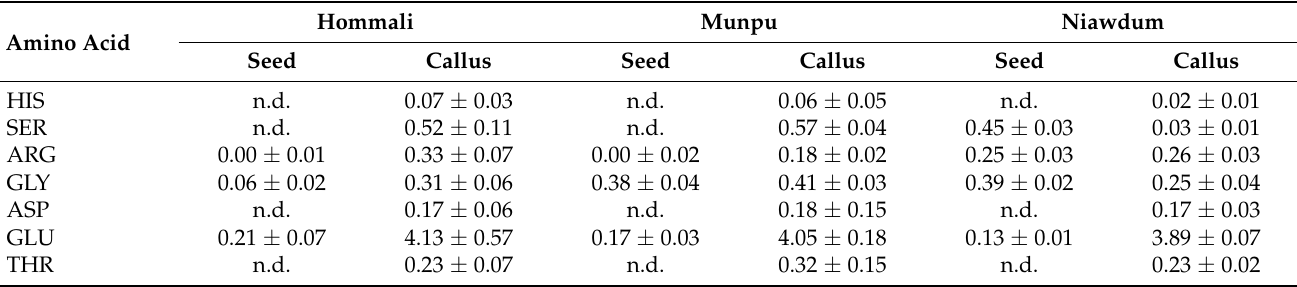
Table 4. Amino acids analysis by UPLC (mM/mL